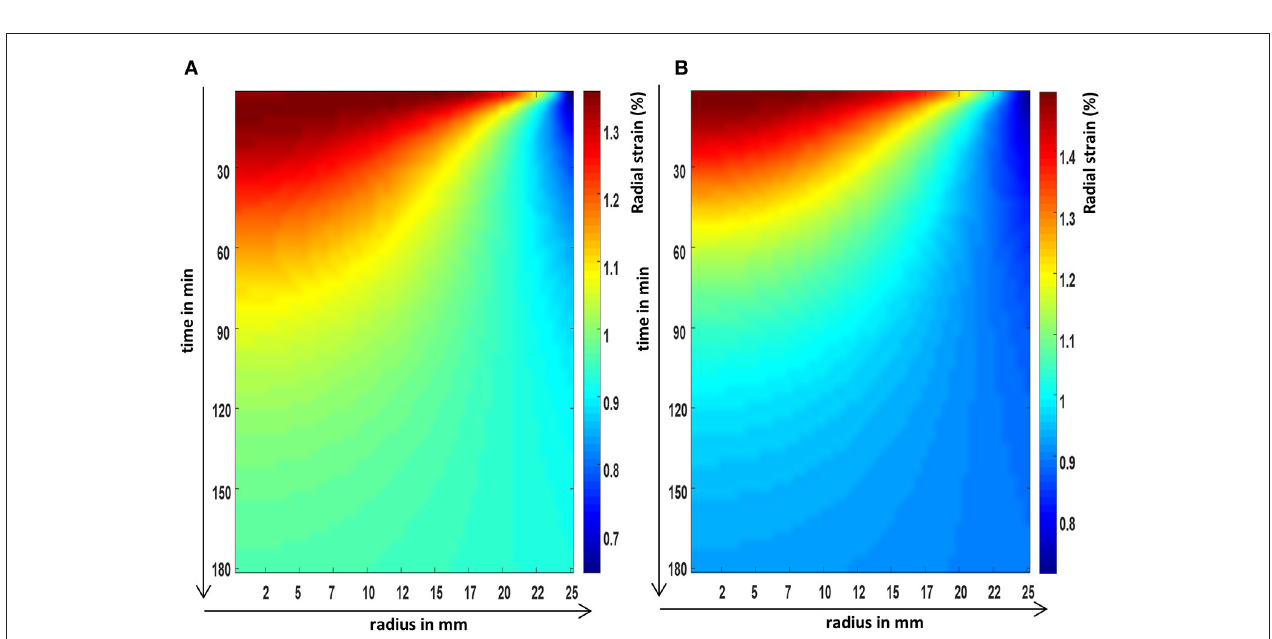
FIGURE 4 | The FEM predictions of the radial strain evolution over time, at the axial center, and across the radius of a cylindrical poroelastic sample subjected to a constant axial stress (A) and an equivalent constant axial strain (B) .